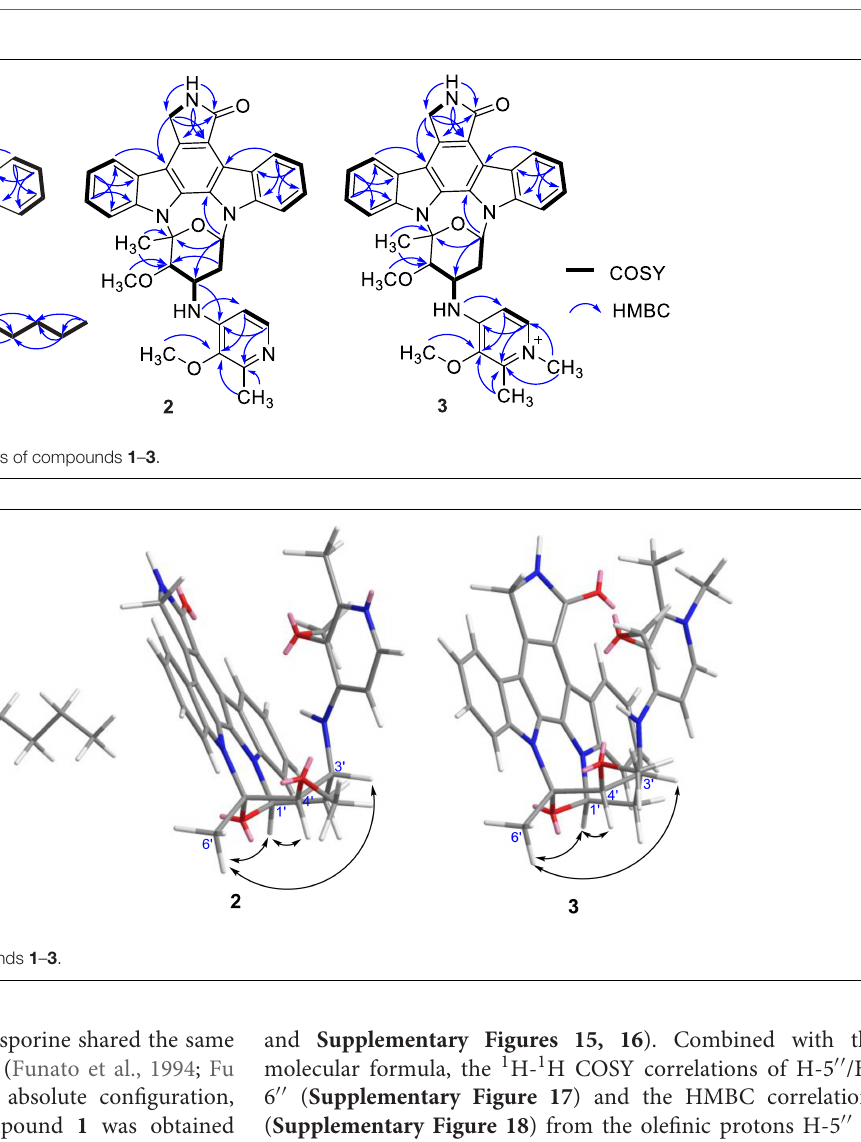
6 (cid:48)(cid:48) ( Supplementary Figure 17 ) and the HMBC correlations ( Supplementary Figure 18 ) from the olefinic protons H-5 (cid:48)(cid:48) to